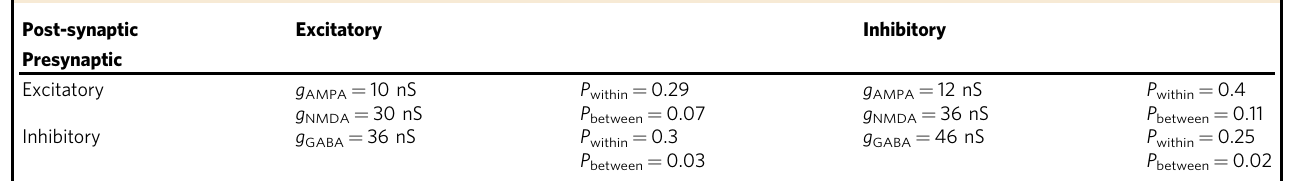
Table 2 Connectivity in the simulated multilayer